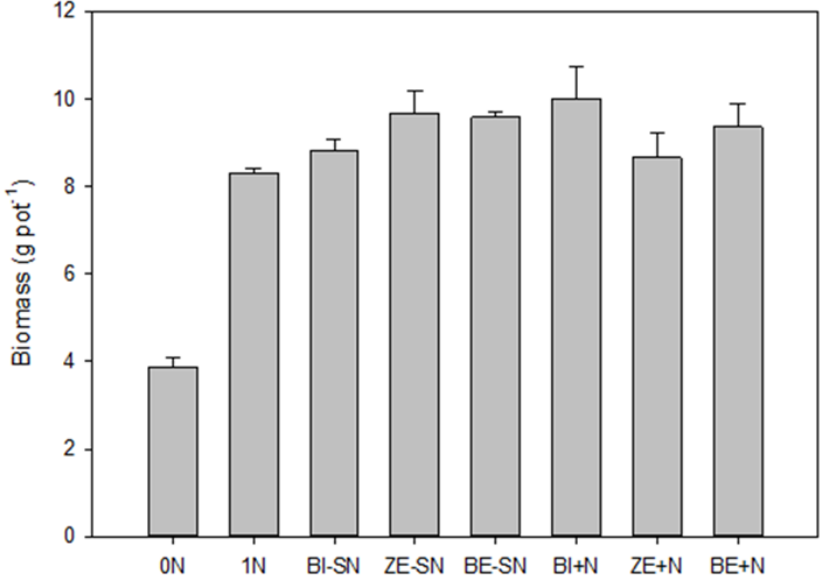
Figure 1. Plant biomass for each treatment at harvest. Error bars are standard error (n = 3). 0N = no fertilizer, 1N = full mineral N fertilizer, no sorbent, BI = biochar sorbent, ZE = zeolite sorbent, BE = bentonite sorbent. When sorbent and N fertilizer are both mixed into the soil separately, -SN is added. When N fertilizer is applied sorbed with the sorbent +N is added.